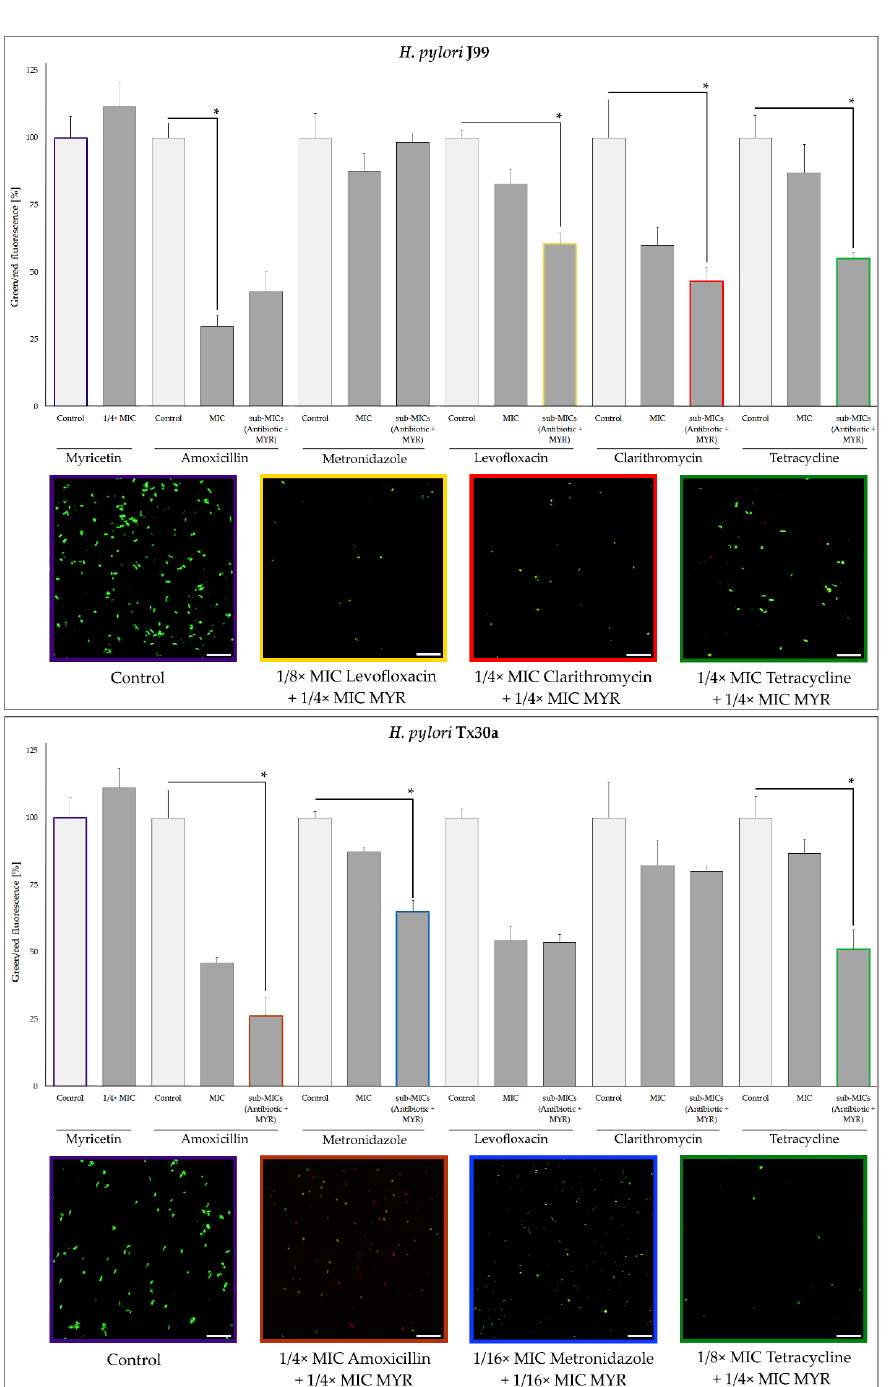
Figure 7. Graphical representation of changes in cell viability of reference H. pylori J99 and Tx30a strains when exposed to MICs of antibiotics or a combination of sub-minimal concentrations (sub- MICs) of the selected antibiotic with 1/4× MIC of myricetin (MYR). Fluorescence in the “control” and “1/4× MIC” samples collectively labeled as “myricetin” is the mean of all other experiments, being their joint element. Bacterial cells were stained with a LIVE/DEAD kit. The scale bar shows 20 µm. Results are presented as means ± standard deviations from three independent, biological experiments. * Indicates statistically significant difference ( p ≤ 0.05).